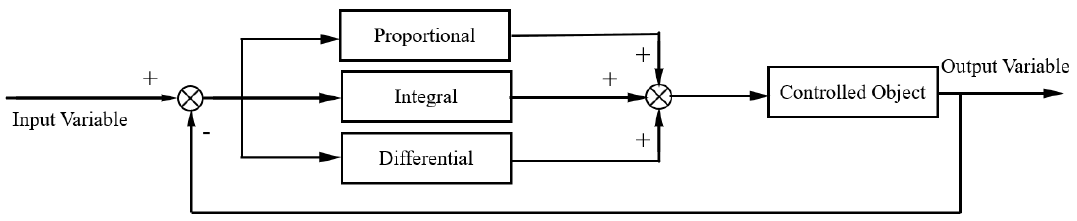
Figure 2. Proportional–integral–differential (PID) control principle.